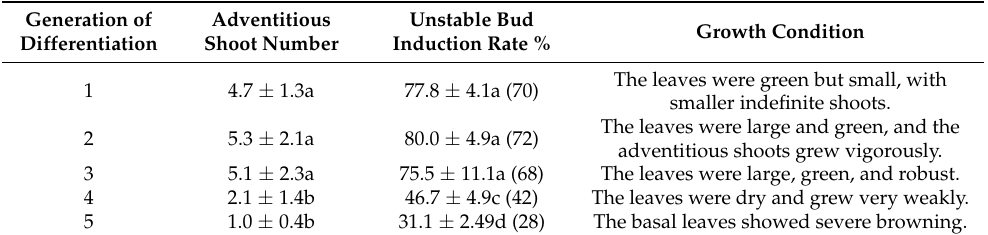
Table 5. Callus-induced regeneration of adventitious shoots with respect to the bud number, bud induction rate, and growth condition.